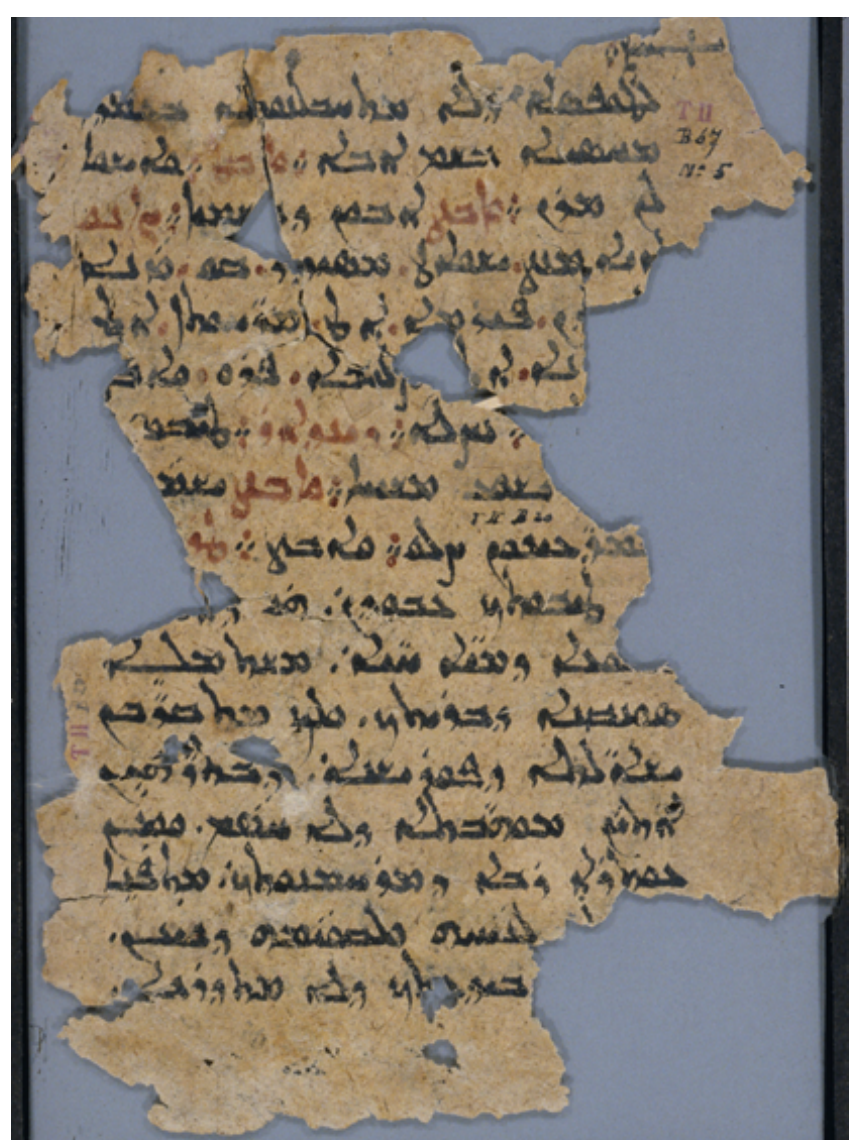
Figure 4 SyrHT 66 side (b) with rubric Sogdian